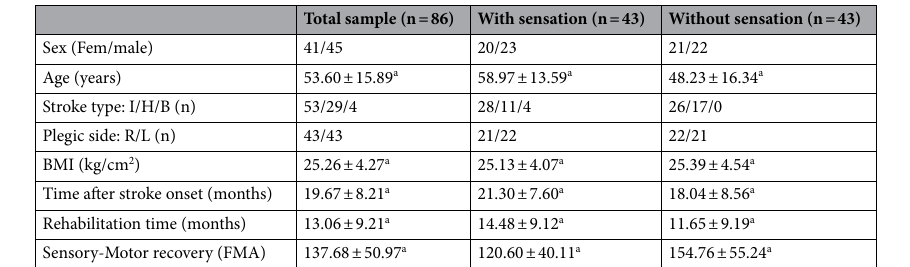
Total sample (n = 86) With sensation (n = 43) Without sensation (n =